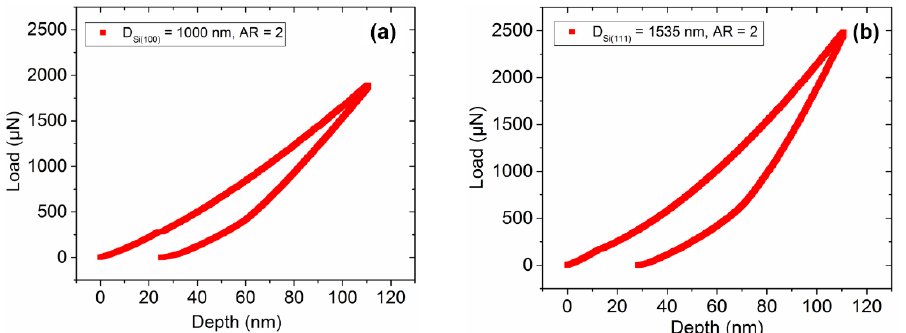
Figure 4. Measured nanoindentation curves by applying a maximum displacement of 110 nm performed on silicon pillars with different crystal orientations (i.e., Si (100) ( a ) and Si (111) ( b )) with an aspect ratio of 2 (D: diameter, AR: aspect